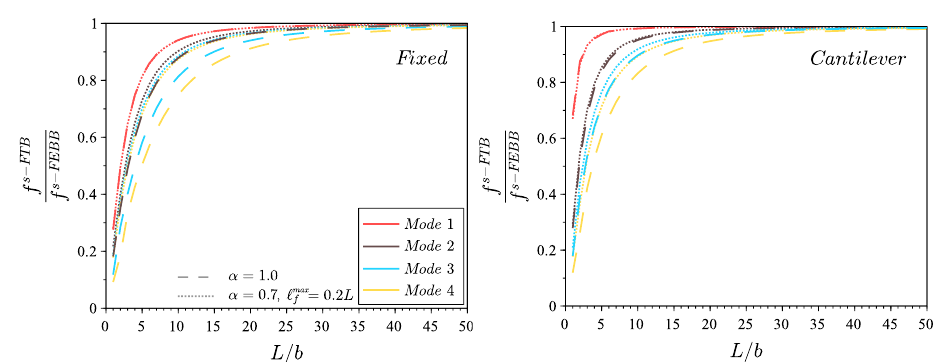
Figure 9. Comparison of the frequency value of first four modes for s-FTB and s-FEBB models for the fixed scheme and the cantilever scheme for α = 0.7 and (cid:96) max CTB and CEBB models (s-FTB and s-FEBB models with α = 1.0). Table 4. Geometric condition L / b of the beam with a difference between the Timoshenko model and the Euler–Bernoulli model less than 5%, for classical ( α = 1.0) and fractional ( α = 0.7, (cid:96) max approaches (see also Figure